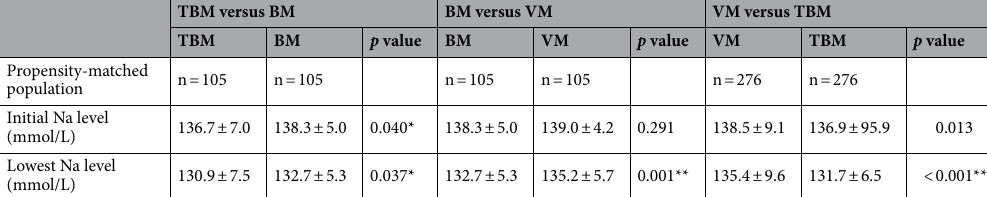
Age was significantly different between the three subgroups (TBM vs. BM vs. VM, 44.7 ± 18.6 vs. 52.1 ± 18.8 vs. 35.6 ± 14.2 years, p < 0.001). There were more females in the VM group than in the TBM group (49.9% vs. 40%, p = 0.001). Serum WBC count was significantly higher in the BM group than in the TBM and VM groups (13.2 ± 11.5 vs. 9.0 ± 6.1 vs. 8.7 ± 4.1 × 10 3 /μL, p < 0.001). Serum LDH level was significantly higher in the TBM group than in the VM group (503.8 ± 1078.0 vs. 387.2 ± 627.9 U/L, p = 0.013). Serum procalcitonin level had a strong trend to be higher in the BM group than in the VM group (7.1 ± 19.0 vs. 1.5 ± 9.0 ng/ml, p = 0.056). In CSF analysis, WBC count was significantly different between the BM and VM groups (1276.5 ± 2150.7 vs. 368.5 ± 7797.4, p < 0.001), and glucose level was significantly lower in the TBM group than in the VM group (51.9 ± 23.5 vs. 62.2 ± 24.8 mg/dL, p < 0.001). The VM group had lower LDH level than the BM group (61.5 ± 249.0 vs. 225.0 ± 389.9 U/L, p < 0.001), and the protein levels were significantly lower in the VM group than in the TBM and BM groups (78.8 ± 244.0 vs. 306.6 ± 795.7 vs. 240.1 ± 266.9 mg/dl, respectively, p < 0.001). In the TBM group, the positive rates of CSF tuberculosis cultures and PCR tests were 12.5% and 11.4%, respectively. The positive rate of Xpert® MTB/RIF was 13.5%. Among the 295 TBM patients, 39 (13.2%) were diagnosed as definite TBM, 112 (38%) were diagnosed as probable TBM, and 144 (48.8%) were diagnosed as possible TBM. VZV PCR in the CSF was positive in 3.6% of the TBM group compared with 12.5% of the VM group ( p = 0.049). Initial and lowest serum sodium levels: cross‑sectional analysis. The initial serum sodium level was significantly lower in the TBM group compared with the BM and VM groups (136.9 ± 5.9 vs. 138.3 ± 4.7 vs. 139.0 ± 3.1 mmol/L, p < 0.001 and p = 0.041, respectively), but there was no difference between the BM and VM groups. In analysis of the lowest serum sodium level, the significant difference between the TBM and VM groups was maintained (131.8 ± 6.4 vs. 137.4 ± 3.7 mmol/L, p < 0.001), while the sodium level was significantly lower in the BM group compared with the VM group (133.1 ± 5.1 vs. 137.4 ± 3.7 mmol/L, p < 0.001) (Table 1). However, there was no difference in lowest sodium level between the TBM and BM groups.